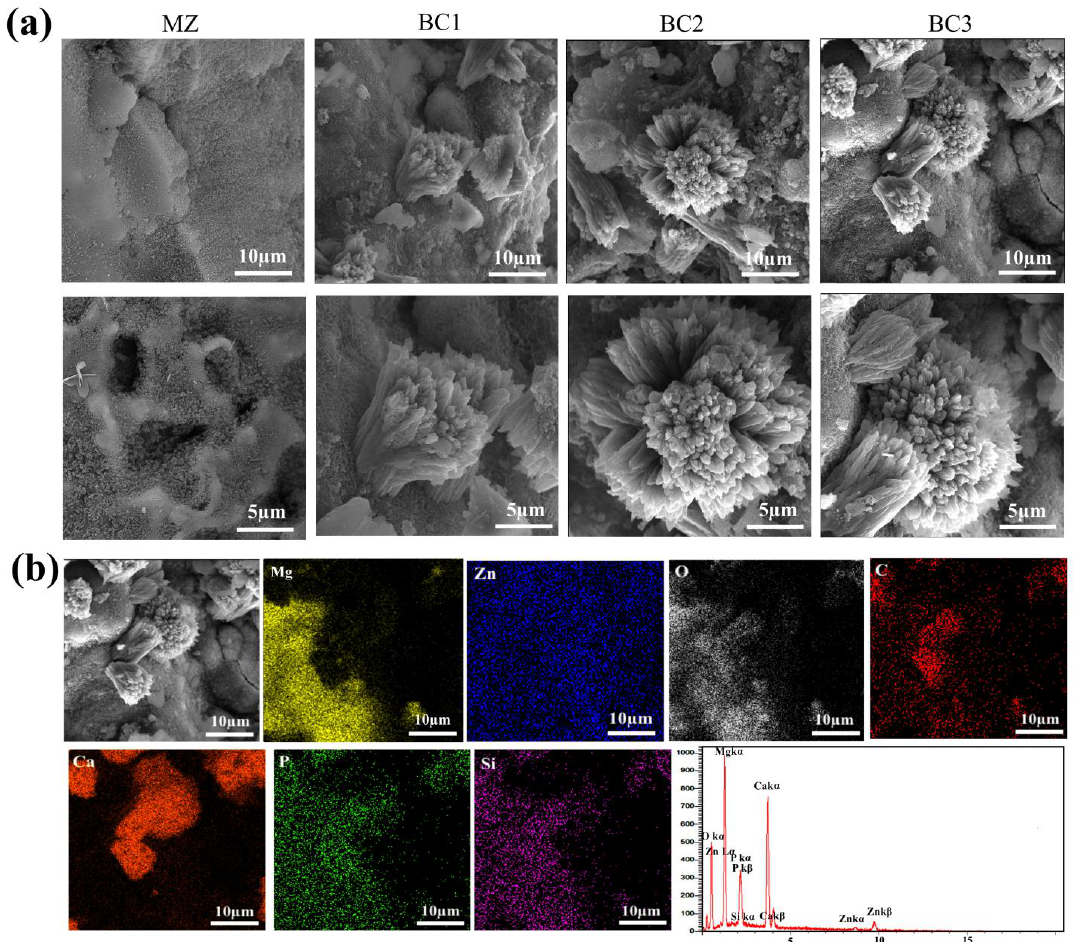
Figure 10. ( a ) SEM images of various composites after 21 days of exposure to SBF solution in magnification ×5000 and ×10,000, and ( b ) SEM and EDS analysis of BC2 composites after exposure to SBF solution.